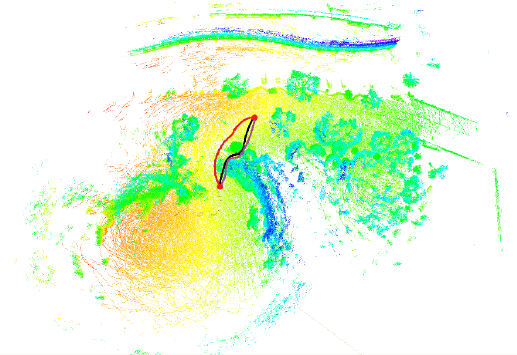
Figure 10. Results of Path Planning Experiments.